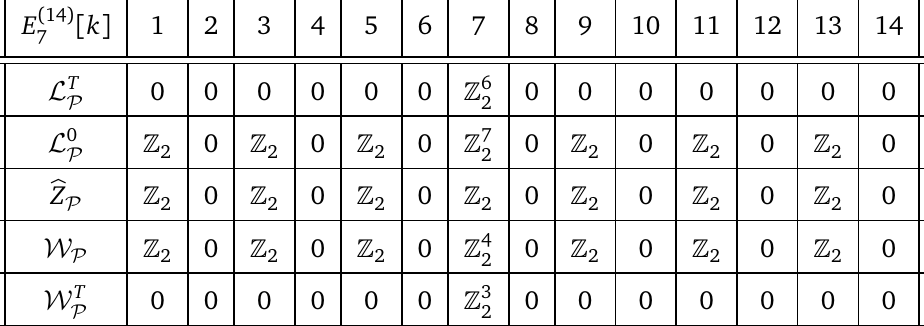
Table 11: Various contributions to the defect group for the untwisted punctures ( 14 ) [ k ] of type E P N = ( 2,0 ) theory. The columns parametrize different values of 7 7 k . The results can be extended beyond this table as they only depend on k ( mod 14 )